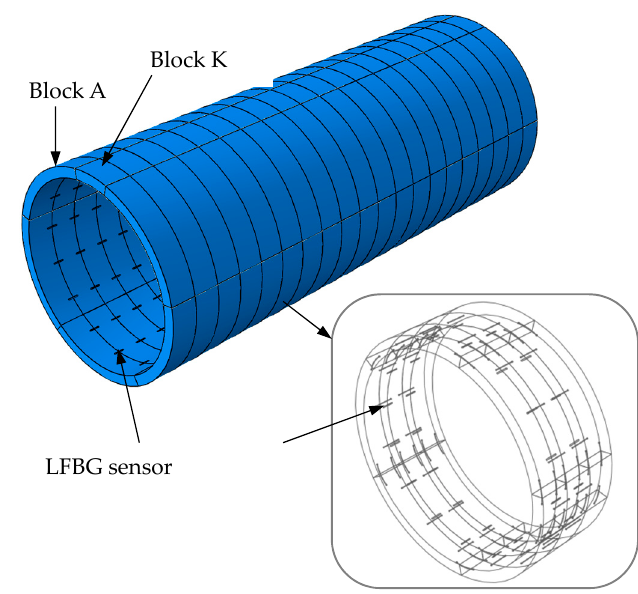
Figure 7. The segment ring model.